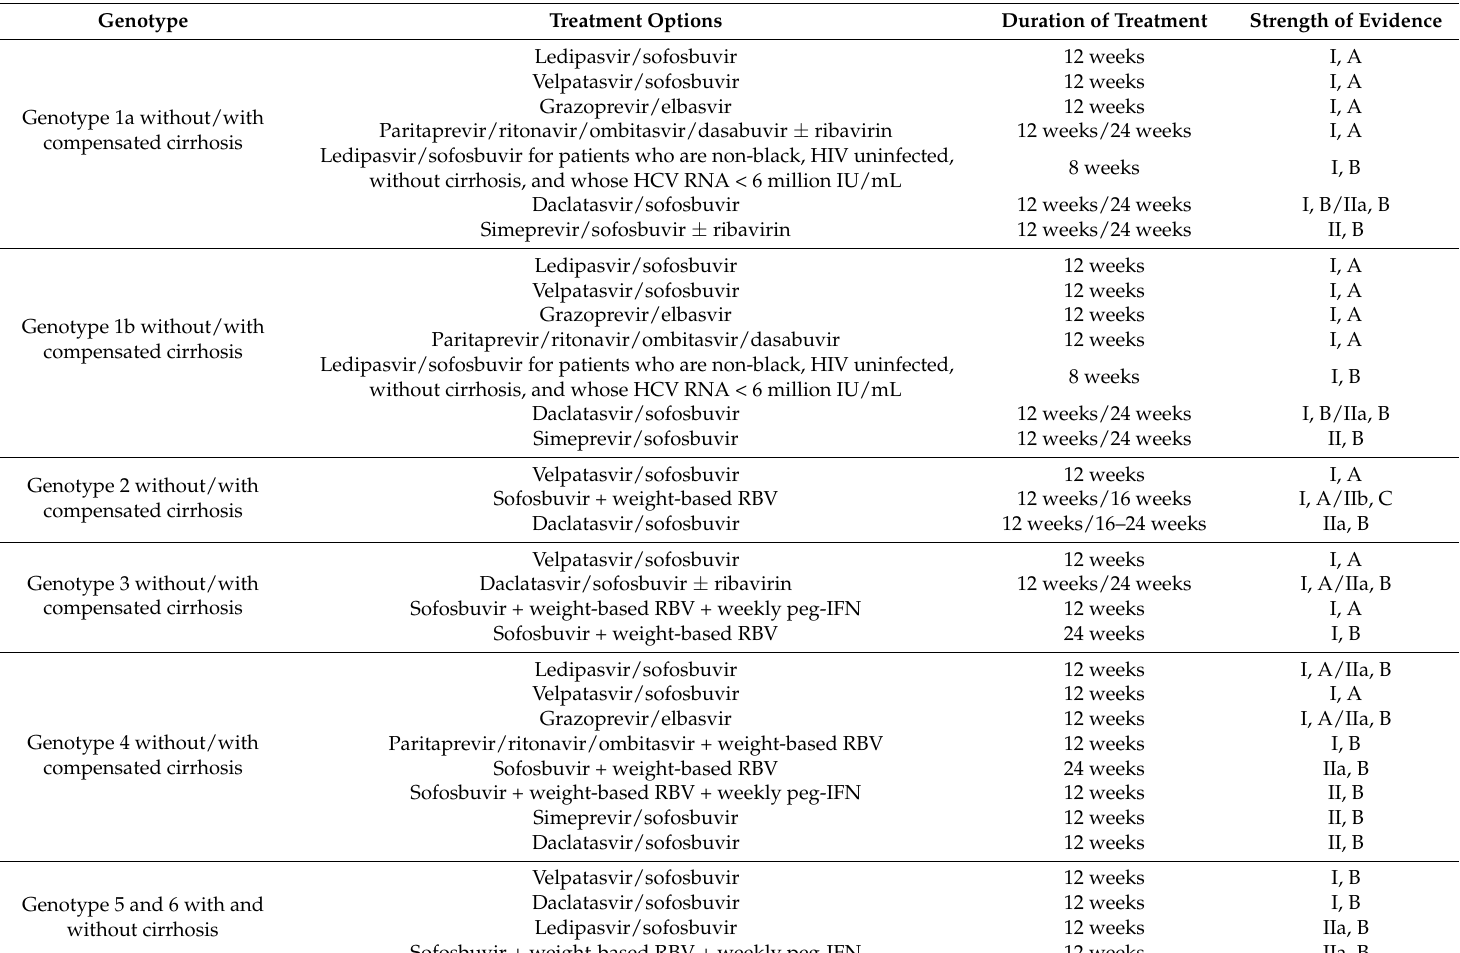
Table 1. Recommended treatment options for HCV infection in treatment-naïve patients based on EASL and AASLD/IDSA treatment guidelines.